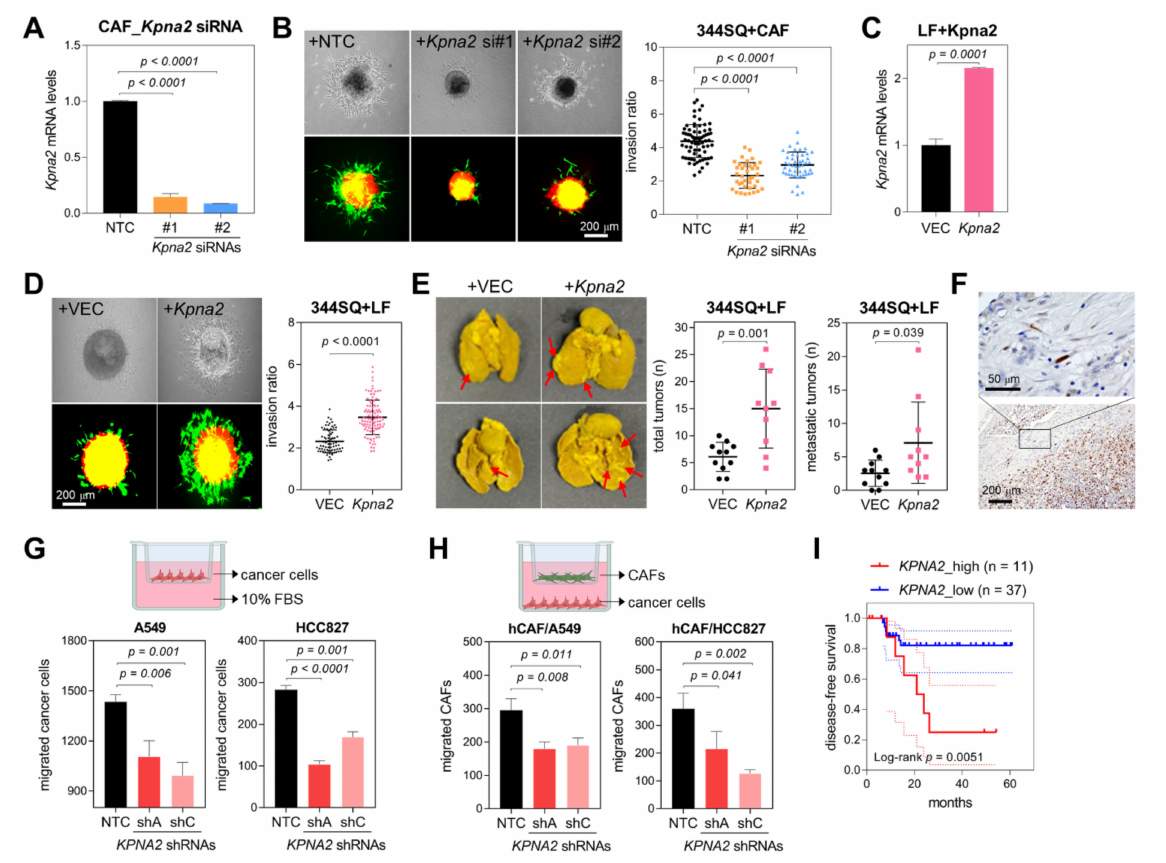
Figure 5. Effects of KPNA2 on CAF activity. ( A ) qRT-PCR analysis of Kpna2 expression in murine CAFs transfected with nontargeting control (NTC) or Kpna2 siRNAs (#1 and #2). Expression levels were normalized to the Rpl32 mRNA level, and values relative to that of the NTCs (set at 1.0) are presented. p , two-tailed Student’s t -test. Data are presented as the mean + SD ( n = 3). ( B ) Spheroid invasion assay in 344SQ cells cocultured with CAFs transfected with NTC or Kpna2 siRNAs (si#1 and #2). These 344SQ cells were labeled with mCherry (red fluorescence), and CAFs were labeled with GFP (green fluorescence). Spheroids made from hanging-drop cultures were seeded on collagen gels and cultured for 2 days. Spheroid invasion ratios (ratio of whole-cell area to central spheroid area) were measured using ImageJ. Mean ± SD (+NTC, n = 71; + Kpna2 si#1, n = 38; si#2, n = 48). p , two-tailed Student’s t -test. ( C ) qRT-PCR of Kpna2 in murine normal lung fibroblasts (LFs) transfected with an empty vector (+VEC) or a Kpna2 -overexpressing vector (+ Kpna2 ). p , two-tailed Student’s t -test. Data are presented as the mean + SD ( n = 3). ( D ) Spheroid invasion assay in 344SQ cells cocultured with LFs transfected with control or Kpna2 -overexpressing vector. Mean ± SD (+VEC, n = 72; + Kpna2 , n = 156). p , two-tailed Student’s t -test. These results are representative of at least three separate experiments. ( E ) Orthotopic injection of 344SQ cells (5 × 10 4 cells/mouse) with LF + VEC or LF + Kpna2 (5 × 10 4 cells/mouse) into syngeneic mice. After 11 days, mice were necropsied, and the lungs were stained with Bouin’s solution to visualize tumor nodules (red arrows, left panels). Graphs show total and metastatic tumor nodules. Mean ± SD (+VEC, n = 11; + Kpna2 , n = 10). p , two-tailed Student’s t -test. ( F ) Immunohistochemical staining of KPNA2 in lung adenocarcinoma tumor sections. The high-magnification image (upper) shows nuclear staining of KPNA2 in fibroblasts. ( G ) Transwell migration assay in human lung cancer cells (A549 and HCC827) transduced with control (NTC) or KPNA2 shRNAs (shA and shC). Cancer cells were seeded in the inserts, and complete medium